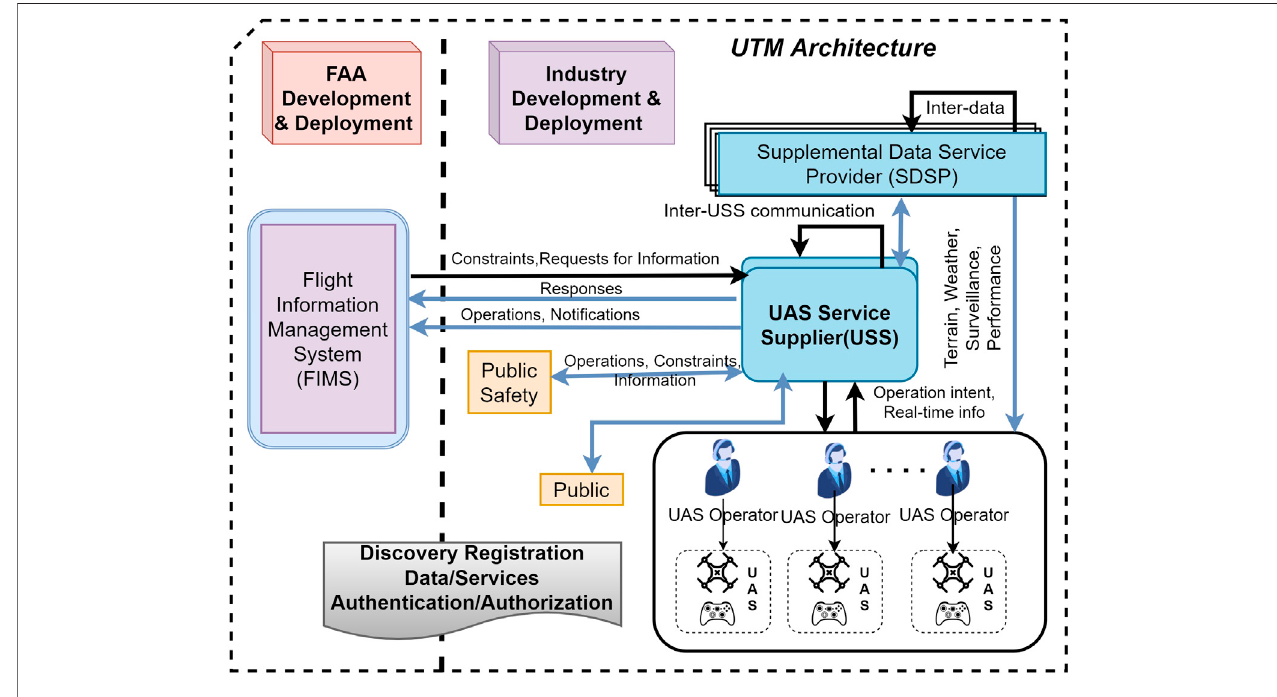
FIGURE 3 | US-based UTM